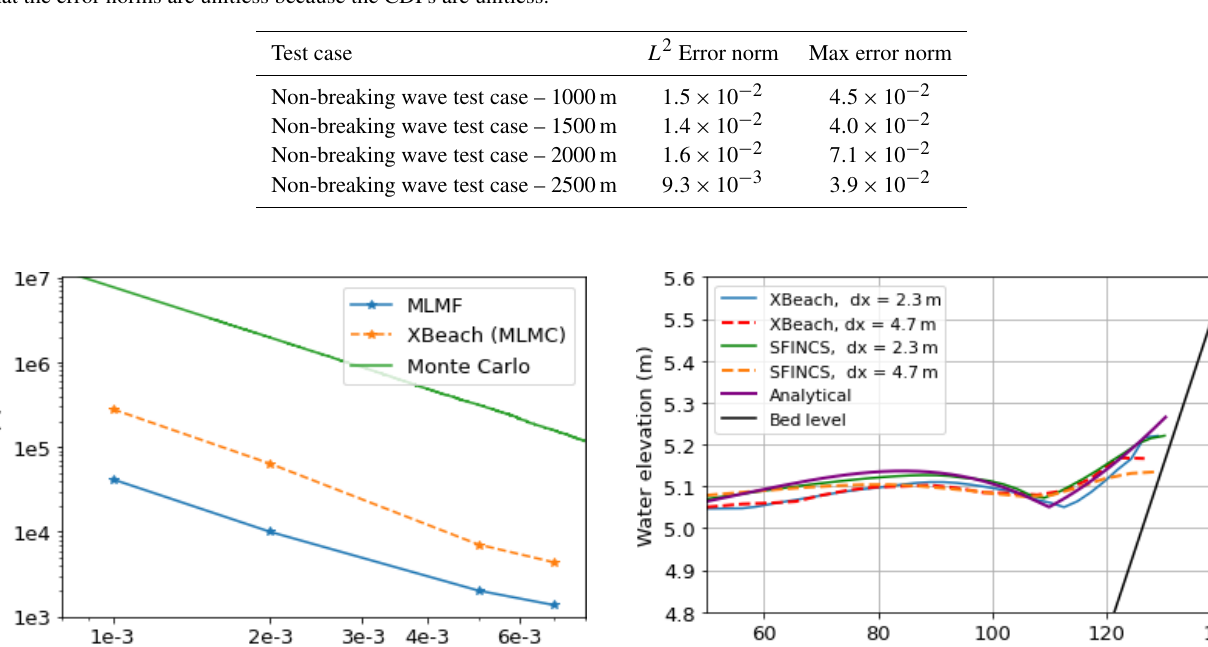
Table 2. L 2 error norm and maximum error norm between the MLMF and Monte Carlo CDFs for the non-breaking wave test cases. Note that the error norms are unitless because the CDFs are unitless.